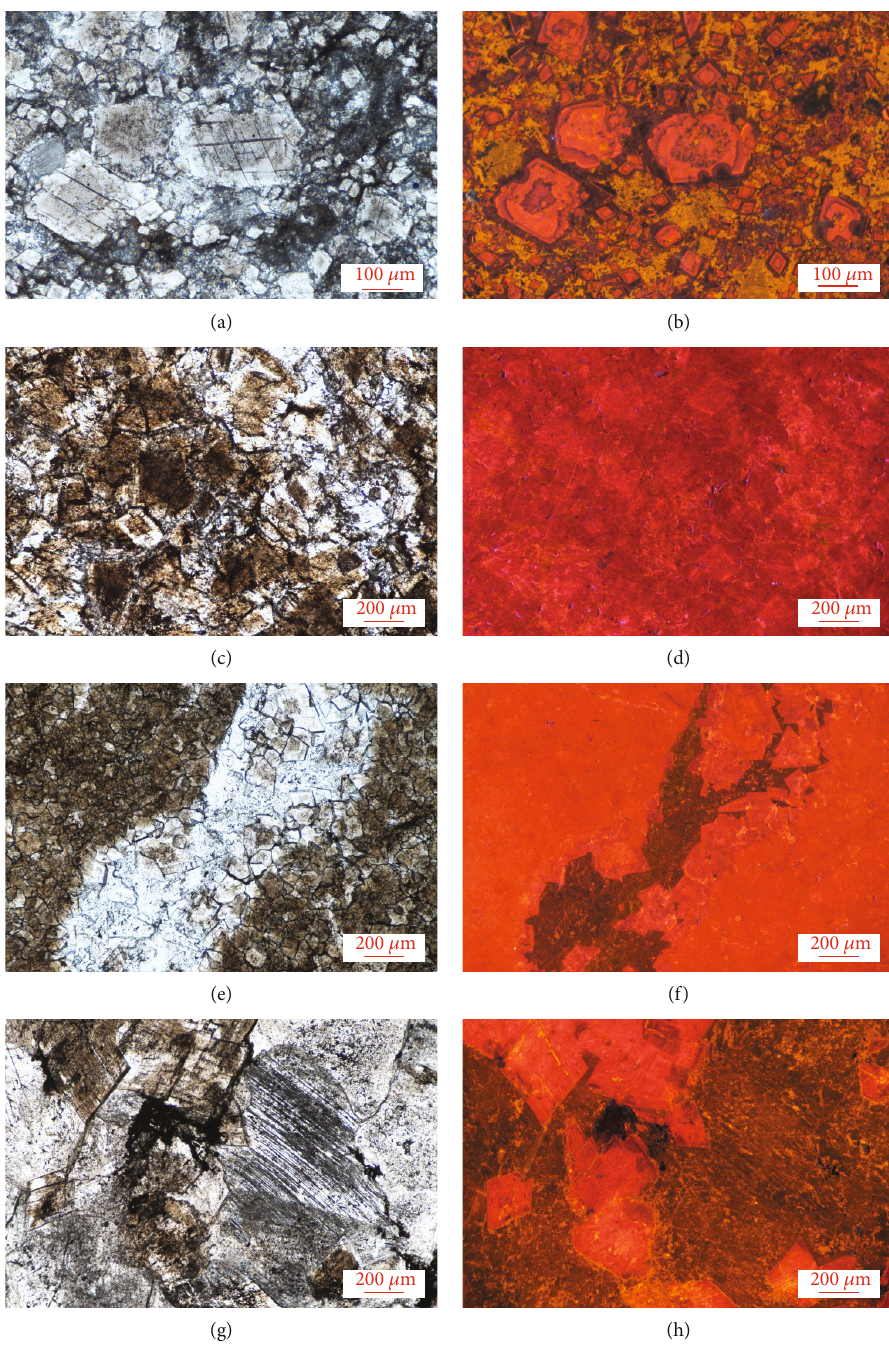
Figure 4: (a) PCD reserves the texture of protogenetic calcite in the HLCH pro fi le. (b) PCD shows brightly orange-red CL in the HLCH pro fi le. (c) CACD in the ERY pro fi le. (d) CCD shows brightly orange-red CL, but CRD shows darkly red CL in the ERY pro fi le. (e) MLD and carbonate vein with coarse-grained calcite in the core and SDD in the rim in the HLCH pro fi le. (f) MLD shows brightly orange-red CL and SDD shows darkly red CL, but CGC is colorless in the HLCH pro fi le. (g) CGC and SDD in the HLCH pro fi le. (h) SDD shows darkly red CL, but CGC is colorless in the HLCH pro fi